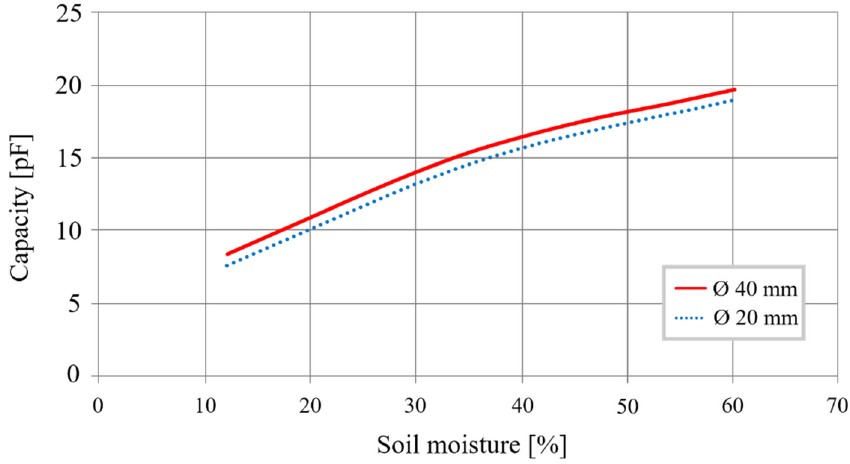
Figure 3. Different sized cylindrical sensor capacity as a function of moisture.